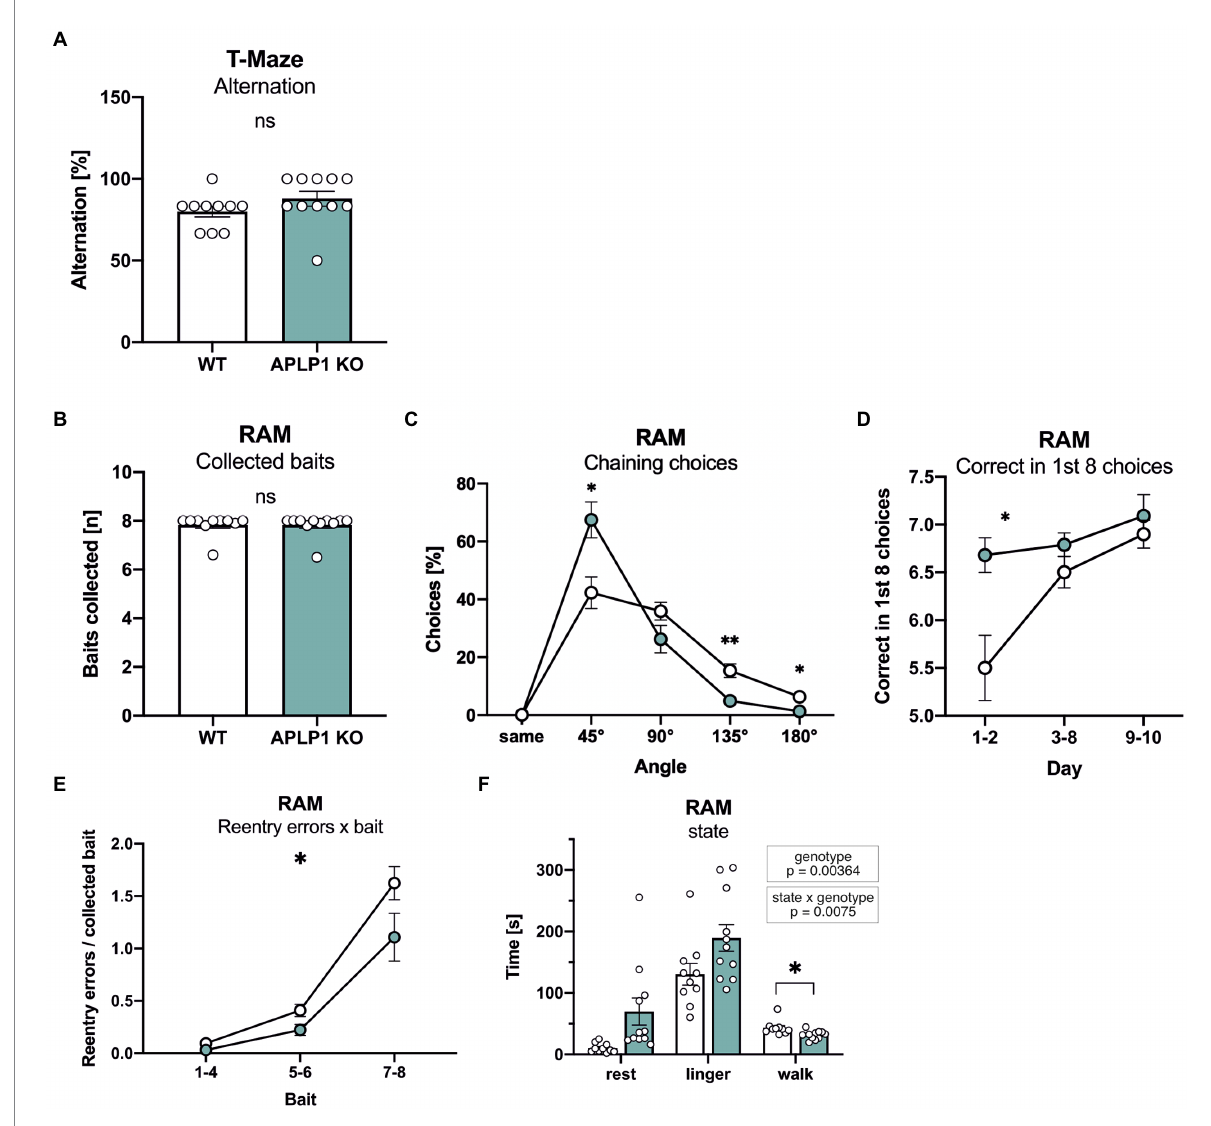
FIGURE 3 APLP1-KO mice exhibit normal short-term memory but use non-spatial search strategies more frequently. (A) : T-Maze alternation test shows no significant difference between genotypes (Mann–Whitney test, ns p = 0.1149). (B) : Radial Arm Maze (RAM). Almost all animals from both genotypes collected all baits during the test (Mann–Whitney test, ns p = 0.8565). (C) : RAM, APLP1-KOs showed a higher tendency for chaining choices than wildtype controls. [geno F (1, 19) = 1.791, ns; angle F (1.141, 21.68) = 74.31, p < 0.0001; angle × geno F (4, 76) = 7.631, p < 0.0001]. (D) : RAM, during training, APLP1-KO mice made more correct among the first 8 choices than wildtype controls, especially at the first two days of training. [geno F (1, 19) = 9.792, p = 0.0055; day F (1.405, 26.69) = 10.20, p = 0.0015; day × geno F (2, 38) = 3.660, p = 0.0352]. (E) : RAM, APLP1-KO animals made less reentry errors than controls during training. [geno F (1, 19) = 5.474, p = 0.0304; bait F (1.110, 21,09) = 74.62, p < 0.0001; bait × geno F (2, 38) = 2.131 ns]. (F) : RAM, APLP1-KO mice spent less time walking, but more time resting and lingering than wildtype controls [geno F (1, 19) = 5.069, p = 0.00364; state F (1.918, 36.43) = 65.03, p < 0.0001; state × geno F (2, 38) = 5.576, p = 0.0075 Data information: number of animals: N = 10 WT, N = 11 APLP1- KO, age of animals 5 months. Data were analyzed using a mixed ANOVA model and are represented as mean ± SEM. ∗ p < 0.05, ∗∗ p <